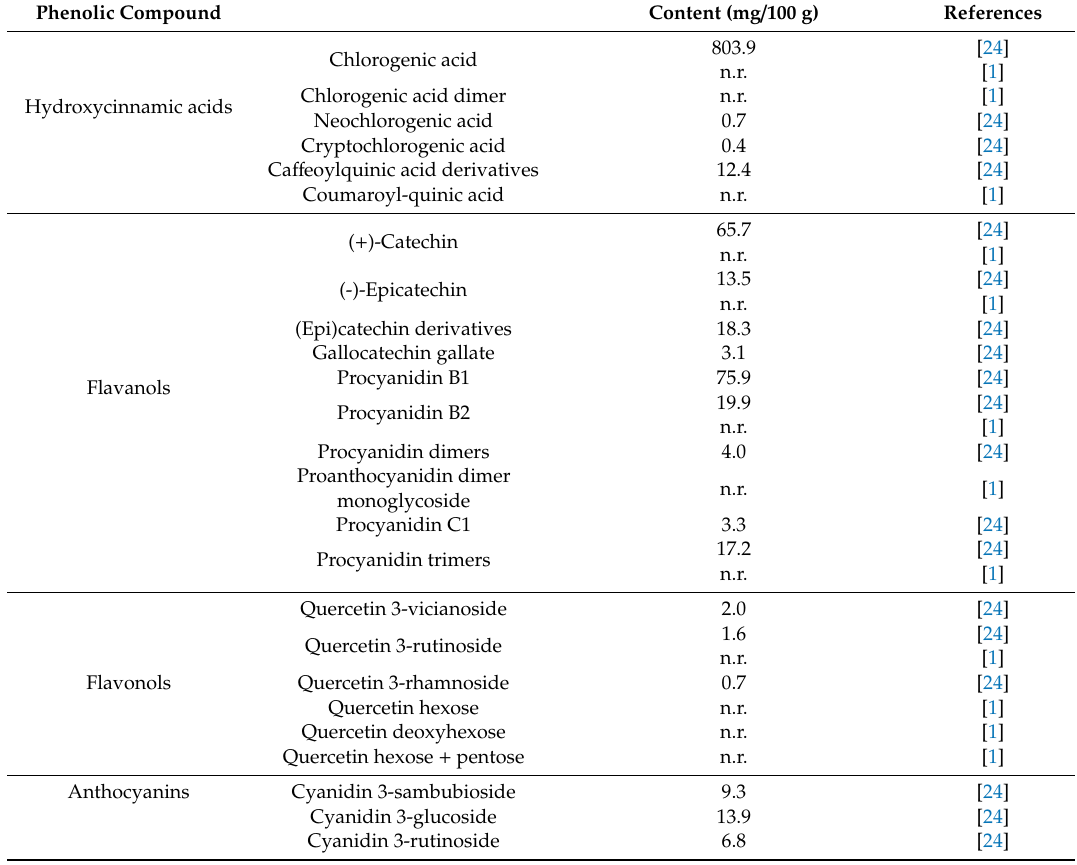
Table 4. Phenolic compounds identified in Viburnum opulus fruit